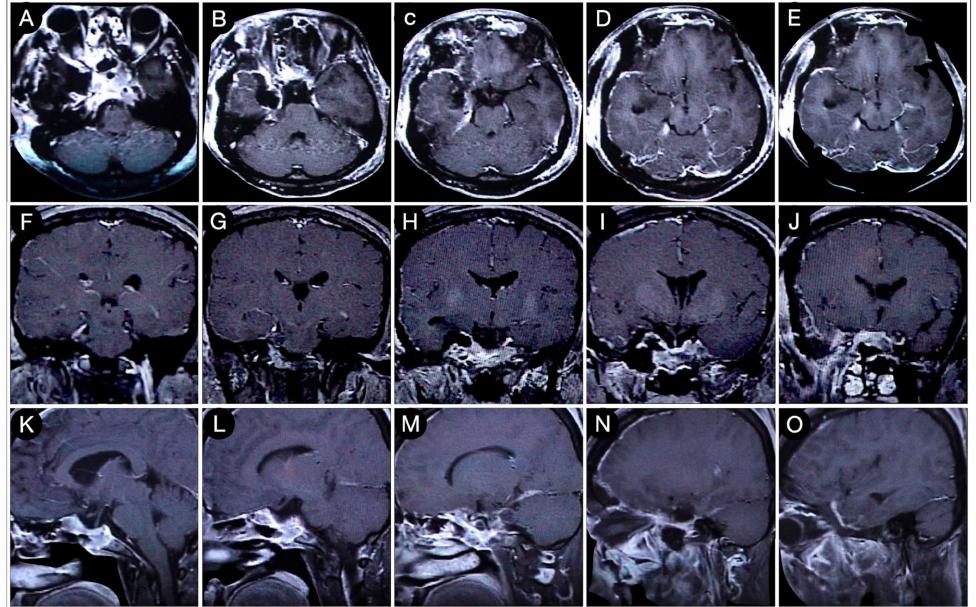
Figure 8. Axial ( A – E ), coronal ( F – J ), and sagittal ( K – O ) T1-weighted contrast-enhanced MRI after the COZ approach for the resection of the intracranial part of the tumor. Scale bar: 5